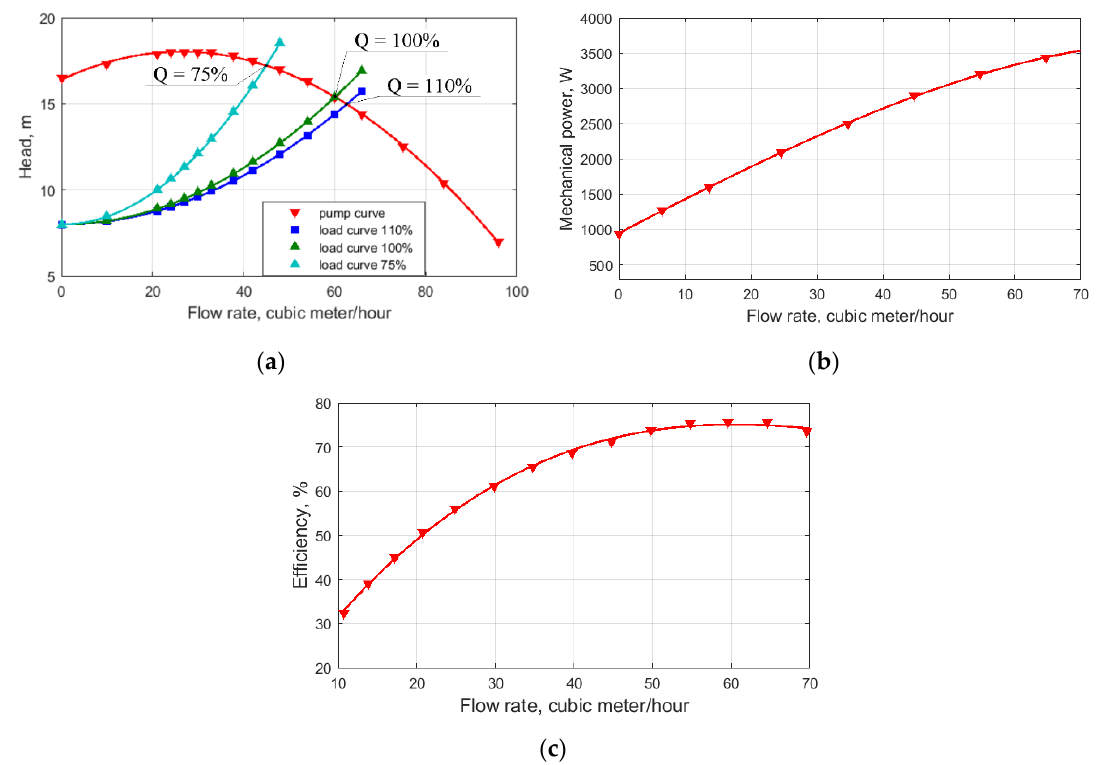
Figure 5. Pump performances: ( a ) Q-H curve; ( b ) pump mechanical power; ( c ) pump efficiency.